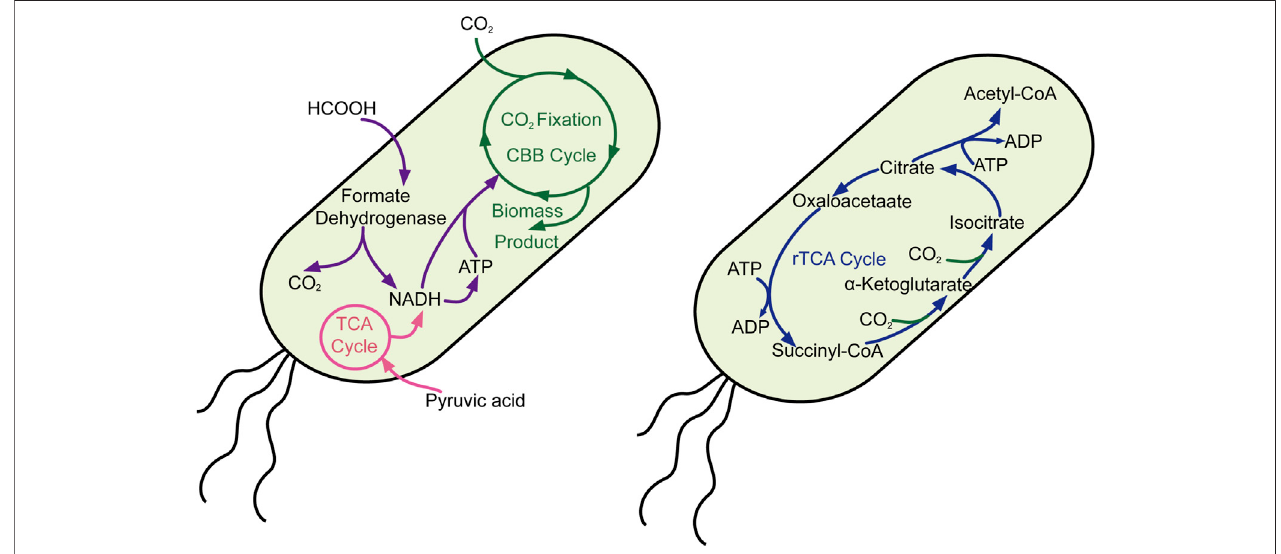
FIGURE 2 | Carbon fi xation in E. coli through the CBB and rTCA cycles. CBB cycle, Calvin – Benson – Bassham cycle; rTCA cycle, reverse citric acid